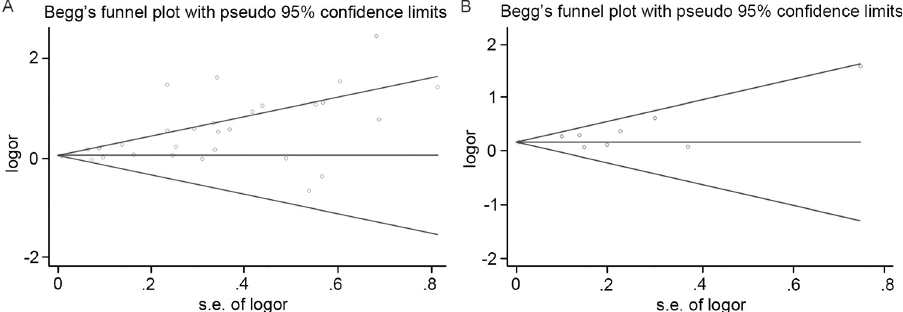
Fig 4. Begg’s funnel plot with 95% confidence limits. A: diabetic nephropathy predicting incident depression. B: depression predicting incident diabetic nephropathy.